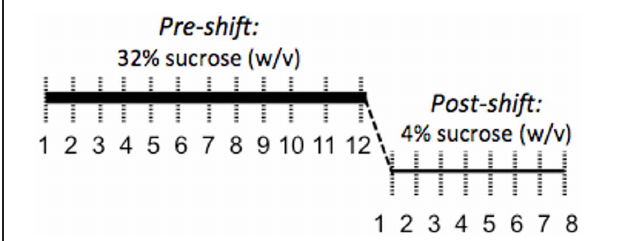
FIGURE 2 | Illustration of the SNC procedure to assess coping response. A high-value 32% sucrose reward was presented for 5min per day for 12 days while licks were counted to evaluate motivation to consume a reward. Following this 12-day acclimation period, the reward was unexpectedly decreased to 4% sucrose. The resulting decrease in consumption of the 4% solution is interpreted as a negative reaction to the violation of positive expectations and a measure of coping response.